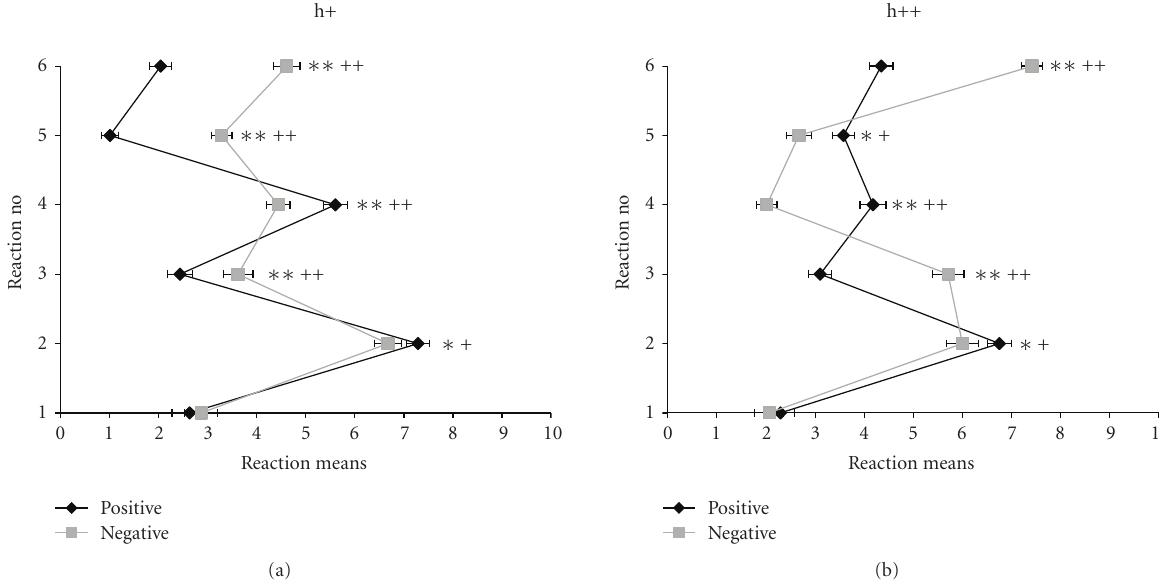
Figure 2: mean reactions + SEM to withdrawal of positive reinforcers (pos) and encounter with negative reinforcers (neg) in conditions of unintentional (h+, (a)) and deliberate (h++, (b)) frustration by humans ( ∗ P < . 05; ∗∗ P < . 01 before Bonferroni correction; + P < . 05; ++ P < . 01 after Bonferroni adjustment of significance